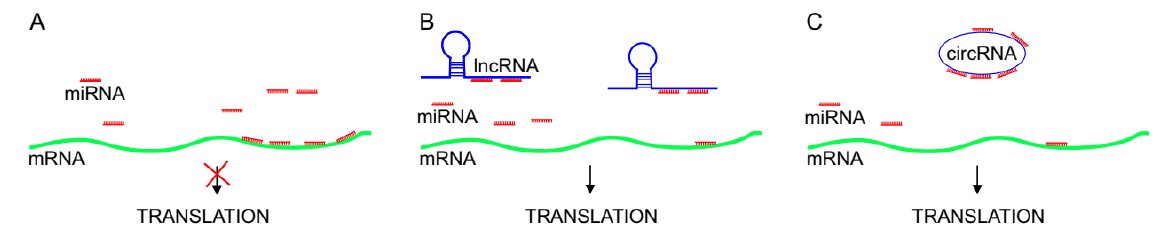
Figure 3. The mechanism of sponging activity of lncRNAs and circRNAs. ( A ) In the absence of lncRNAs, abundant miRNAs bind to the 3′ untranslated region of target transcripts and block their translation. ( B , C ). lncRNAs or circRNAs, when present, outcompete target transcripts in miRNA binding, which results in the rescue of translation blockade of target transcripts.